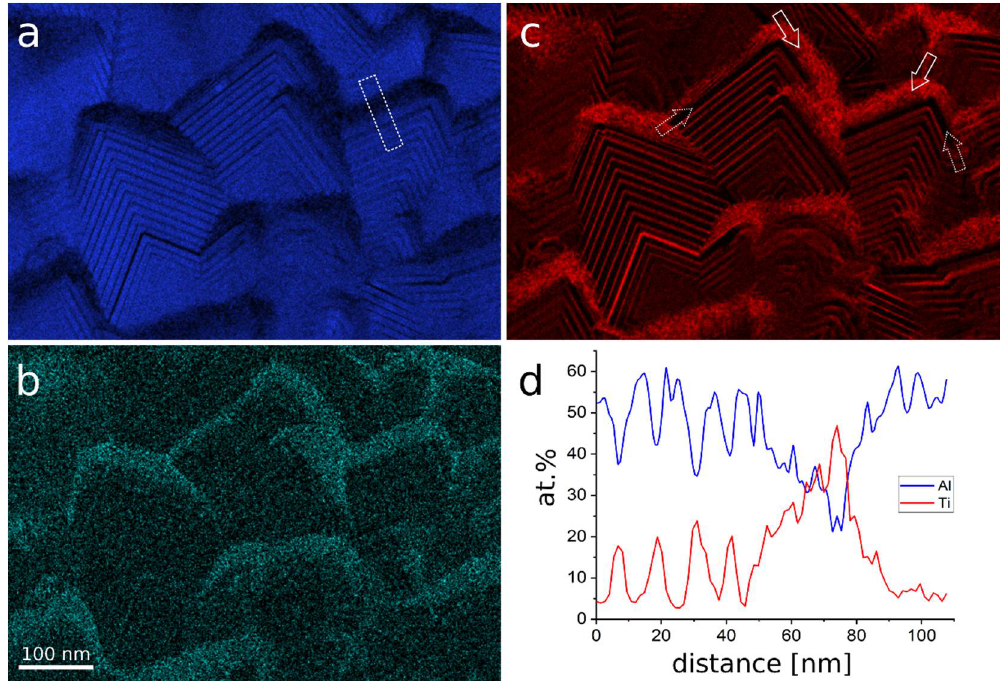
Figure 5. Representative STEM-energy-dispersive X-ray spectroscopy (EDX) maps show qualitative ( a ) Al, ( b ) Ti, and ( c ) Cl element distributions across representative cubic nanolamellar Al x Ti 1− x N grains. A line scan ( d ) was plotted using data integrated in a dashed box. Dashed outline arrows indicate the presence of Al-rich hexagonal nanolayers terminating cubic Al x Ti 1− x N grains, which are followed by polycrystalline Ti-rich and comparatively Cl-rich regions (indicated by solid outline arrows).